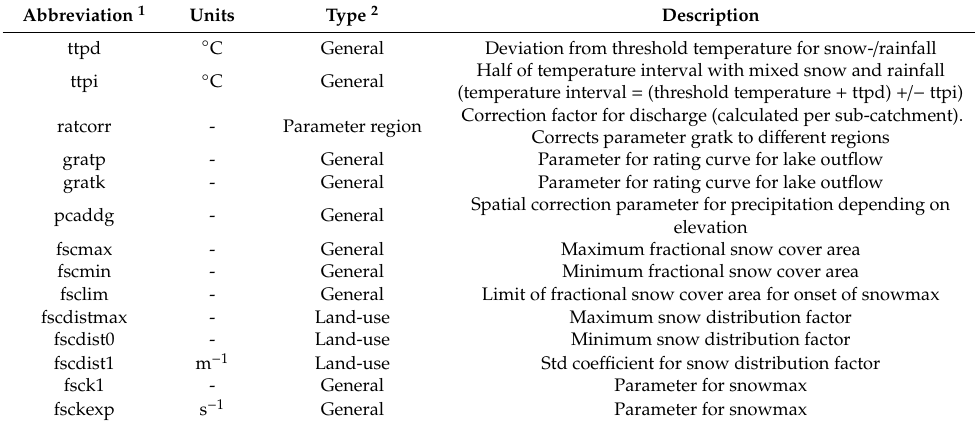
Figure 2. Distribution of parameter values for the 100 best parameter sets obtained during Monte Carlo analysis for the calibration period (1 September 2005–31 December 2010) when parameters were given an upper range limit of: ( a ) 0.3 (pcaddg), ( b ) 1 (ratcorr), and ( c ) 2 (ttpd, ttpi) and 4 (gratk, gratp). Whiskers indicate the maximum and minimum values found during the Monte Carlo analysis among the 100 best parameter sets, while the red line is the mean and the boxes represent the first and third quartile of the value distribution. The parameters were tested in various setups, with di ff erent combinations of input datasets. Some parameters showed little convergence but were important for model performance in di ff erent setups. Table 2. Parameters used for calibration and fractional snow cover area